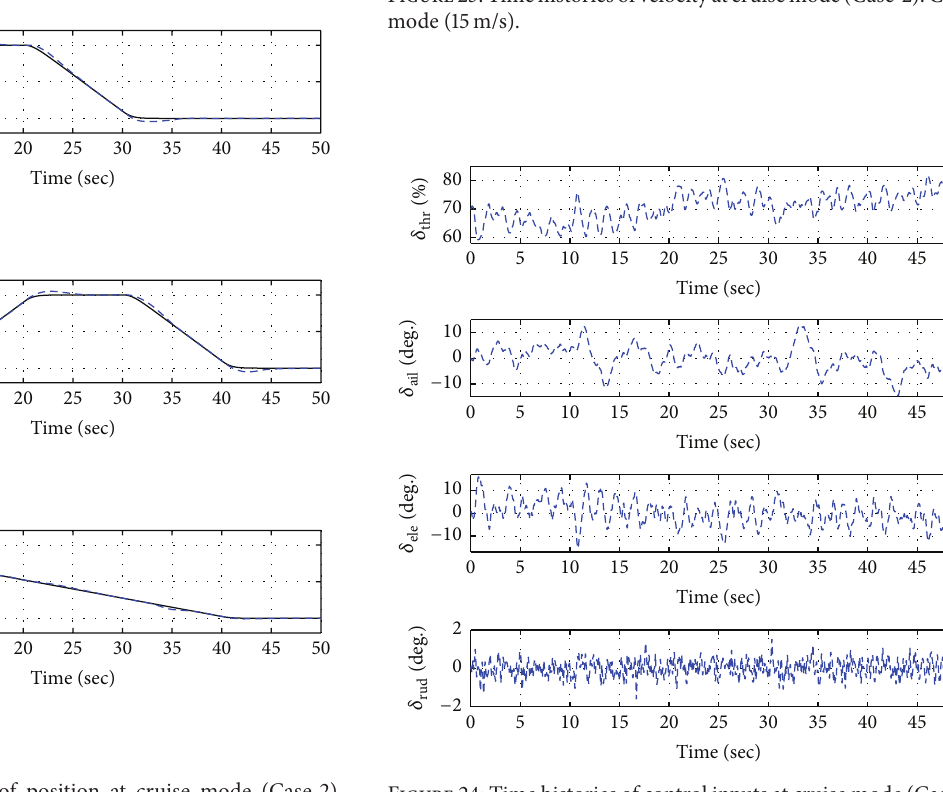
Figure 24: Time histories of control inputs at cruise mode (Case 2). Cruise mode